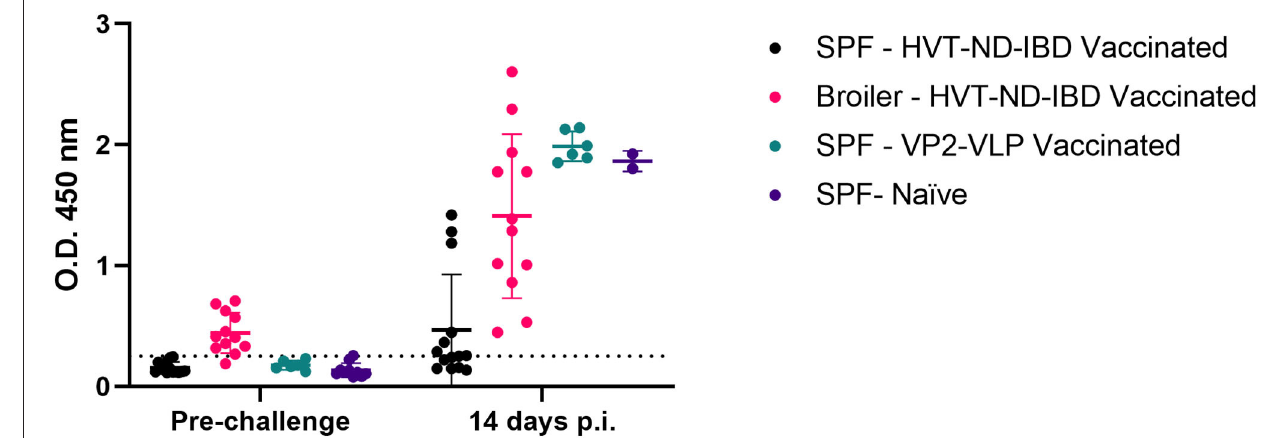
FIGURE 8 | Efficacy of His-VP3-based ELISA in differentiating VP2-vaccinated SPF and broiler chickens before and after challenge. Distribution of O.D. 450 values of SPF and broiler chickens, sera collected before the challenge and after the challenge (14 days p.i.) (SPF-HVT-ND-IBD vaccinated, black; Broiler-HVT-ND-IBD vaccinated, pink; SPF-VP2-VLP vaccinated, green; SPF-Naïve, blue) analyzed with the His-VP3 ELISA. Horizontal and vertical bars: mean ± standard deviation (SD). The positive threshold is indicated with a dotted line (O.D. 450 =